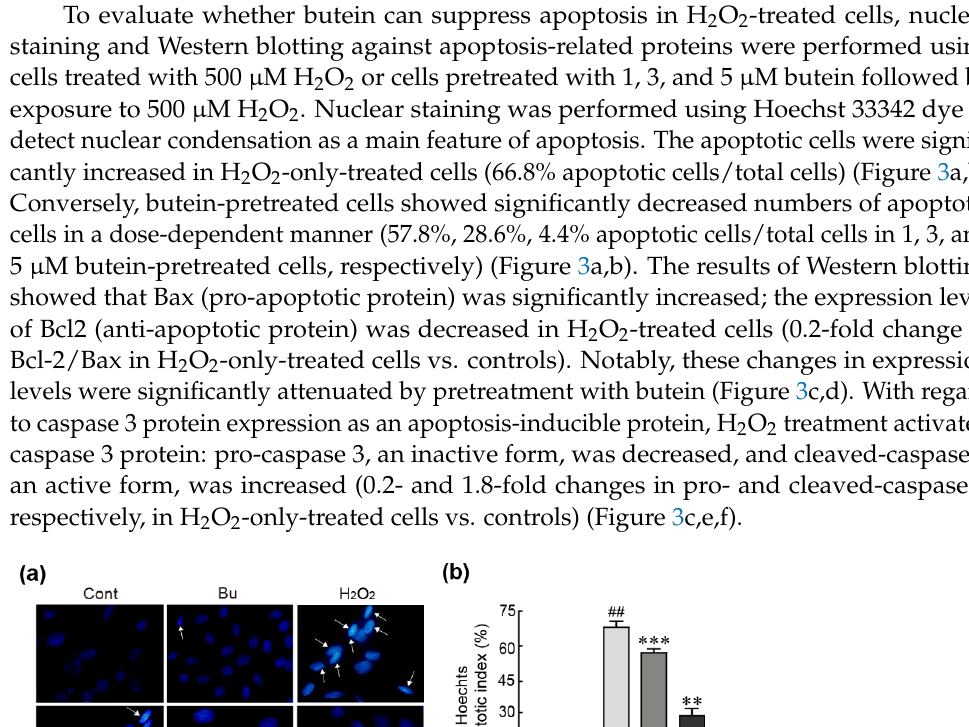
Figure 3. Butein attenuates apoptotic cell death in H 2 O 2 -treated H9c2 cardiomyoblasts. The cells were treated with butein and/or H 2 O 2 ( a ) Nuclear staining was performed by Hoechst staining. The arrow indicates apoptotic cells with nuclear condensation using cells that were treated with butein and/or H 2 O 2 . The cells in at least 10 fields (30 cells per field) were counted in each group. ( b ) The percentage of apoptotic cells versus total cells is shown as the apoptotic index. ( c ) Western blot analysis for the expression levels of apoptosis-related proteins including Bcl-2, Bax, pro- and cleaved caspase 3, and β -actin (loading control). The band densities of the ratio of Bcl-2/Bax ( d ) and pro- ( e ) and cleaved ( f ) caspase 3 proteins were calculated with HD imaging software. The results are shown as the mean ± SEM in triplicate. # p < 0.05 and ## p < 0.01 vs. control group. ** p < 0.01 and *** p < 0.001 vs. H 2 O 2 -only group. Cont; control, Bu; butein. Scale bar, 100 µm. 3.4. Butein Attenuates Oxidative Stress in H9c2 Cardiomyoblasts To determine whether butein inhibits oxidative-stress-induced ROS production in H9c2 cardiomyoblasts, DCFDA dye, an ROS detector, staining was performed in cells treated with butein and/or H 2 O 2 . The results showed that intracellular ROS production detected by green fluorescence was markedly increased in 500 µM H 2 O 2 -only-treated cells. However, pretreatment with butein significantly inhibited ROS production. In particular, 5 µM butein pretreatment reduced ROS production to similar levels in control cells (Fig- ure 4a,b). Western blotting of several antioxidant proteins, including SOD1, SOD2, and catalase, was also performed. The results showed that H 2 O 2 decreased the expression of these proteins, whereas their expression was significantly increased following pretreat- ment with butein (Figure 4c–f). Therefore, butein has potential antioxidant capacity by blocking ROS production and restoring the expression of antioxidant proteins.